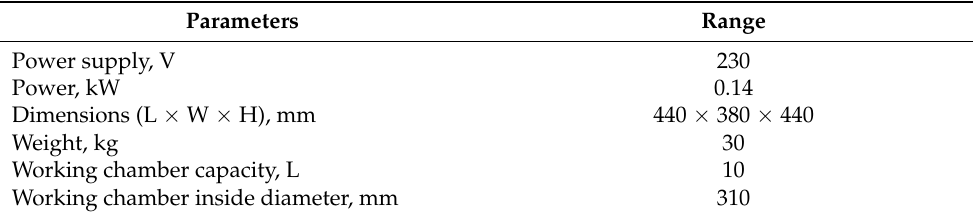
Table 6. Specifications of WE10 type vibratory finishing machine.